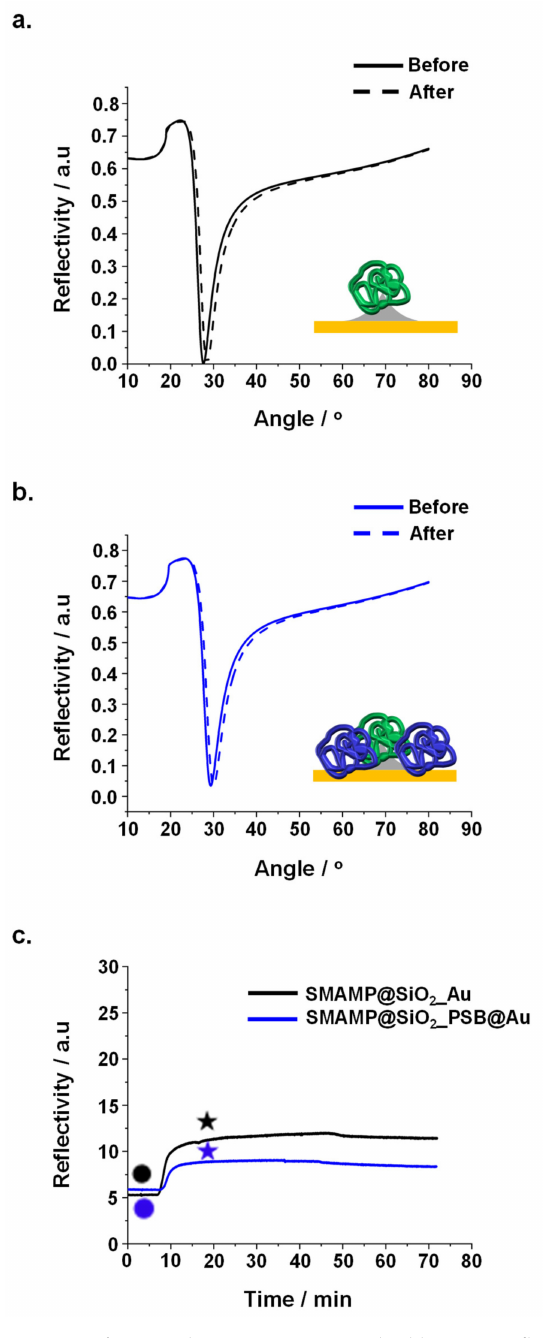
Figure 4. Protein adhesion on surfaces with 2 µ m spacing studied by SPR: reflectivity curves of protein adhesion on ( a ). SMAMP@SiO 2 _Au and ( b ). SMAMP@SiO 2 _PSB@Au . Angular scans before and after exposure to fibrinogen were recorded (solid curves: dry thickness before fibrinogen adsorption, dashed curve: dry thickness after fibrinogen adsorption). ( c ). SPR kinetics curves of fibrinogen adhesion on SMAMP@SiO 2 _Au and SMAMP@SiO 2 _PSB@Au , both with 2 µ m spacing. Circles: time points of protein injection; stars: time points of bu ff er